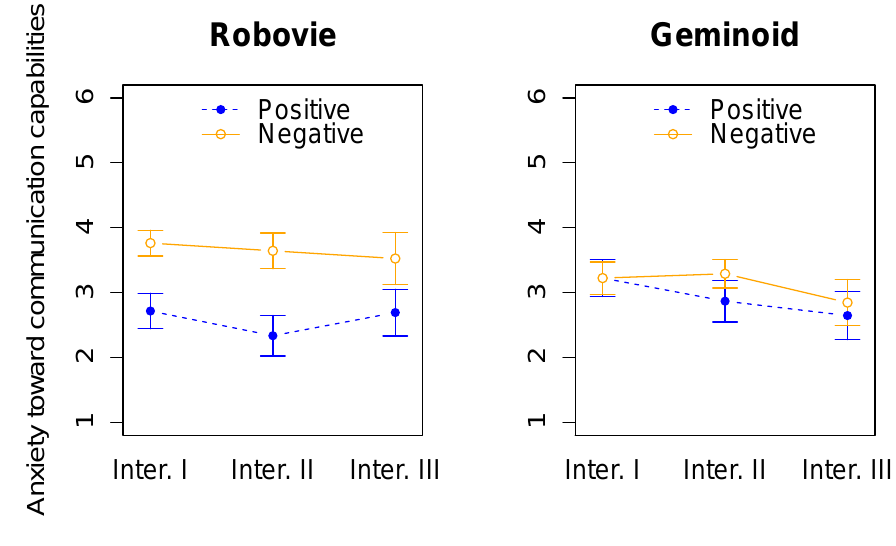
Figure 6: Mean anxiety toward communication capability with 95% confidence intervals measured in each interaction round (Interaction I, II and III) for positive and negative behaviour of both robots. Higher scores indicate higher anxiety toward communication capability of a robot.